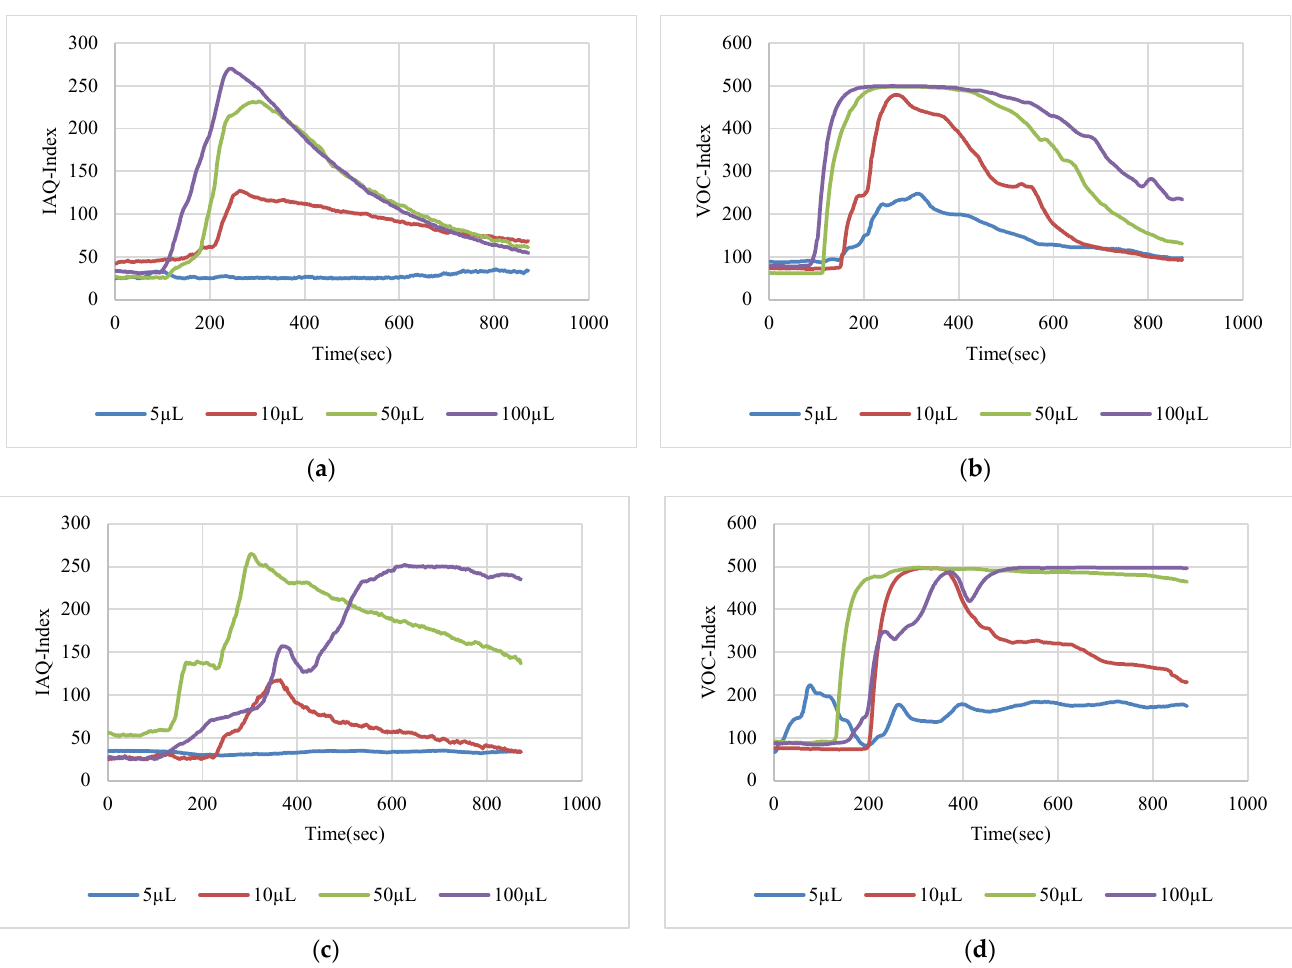
Figure 11. Test results for acetone: ( a ) BME688 40 cm, ( b ) SGP41 40 cm, ( c ) BME688 100 cm, ( d ) SGP41 100 cm.